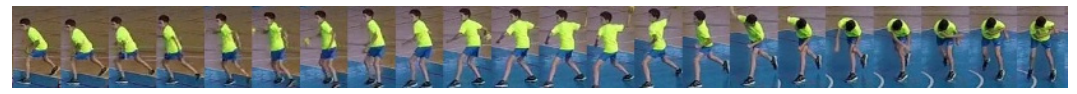
Figure 9. Extracted collage of the most active player’s action.